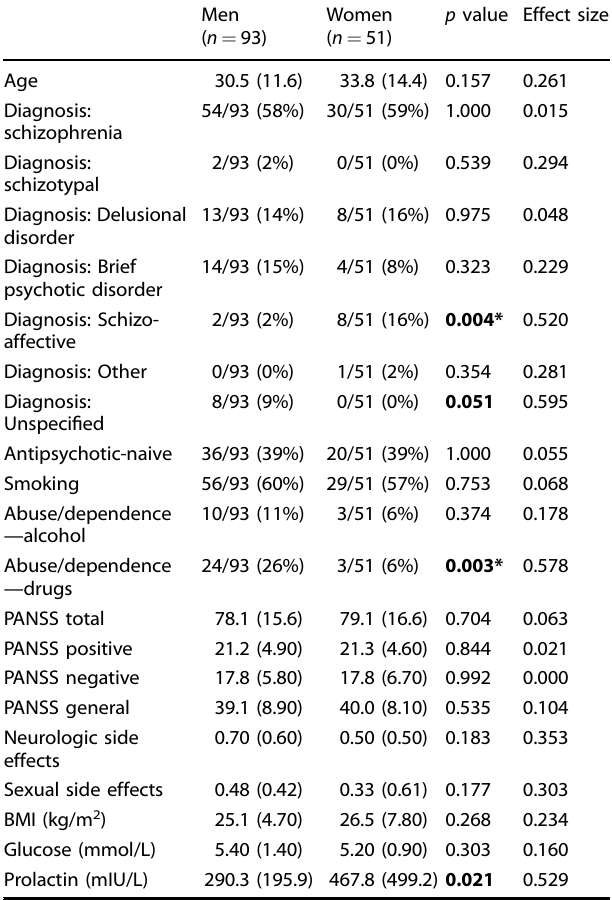
Table 1. Baseline mean (SD) demographic and clinical characteristics by